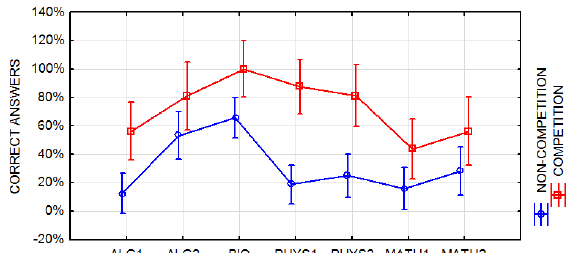
Figure 2. The percentage of correct answers – differences between the groups: Competition and Non-Competition students.